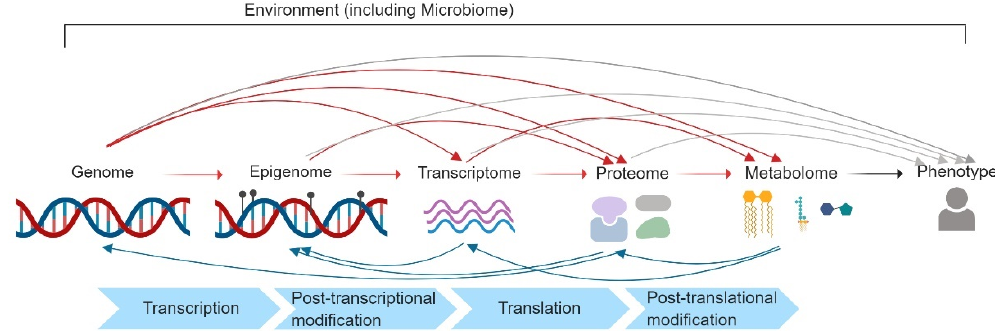
Figure 1. A systems biology view of complex trait etiology. Red arrows reflect all potential causal mechanistic pathways that may be captured by the metabolome assuming a central dogma framework. Gray arrows depict biological pathways that do not act through changes to the metabolome. Blue arrows depict potential sources of reverse causation, or mechanisms that involve time-dependent feedback between omics and do not strictly adhere to the central dogma; the arrows depicted here are non-exhaustive of all potential reverse causation / time-dependent paths. The environment is depicted as a potential force across all of the omic stages; the microbiome is included as a component of the environment, but does not necessarily exert its effects across all omic stages. Image made with Biorender.